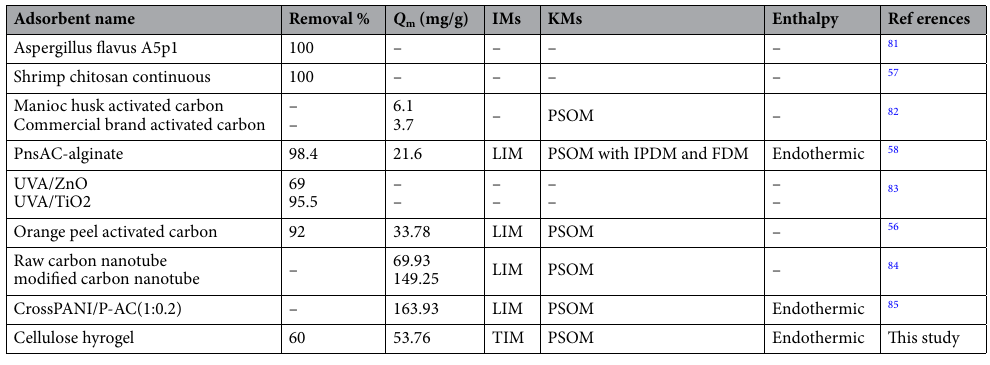
Table 6. Results of the Q m and removal % of DB86 dye of various adsorbents reported in the